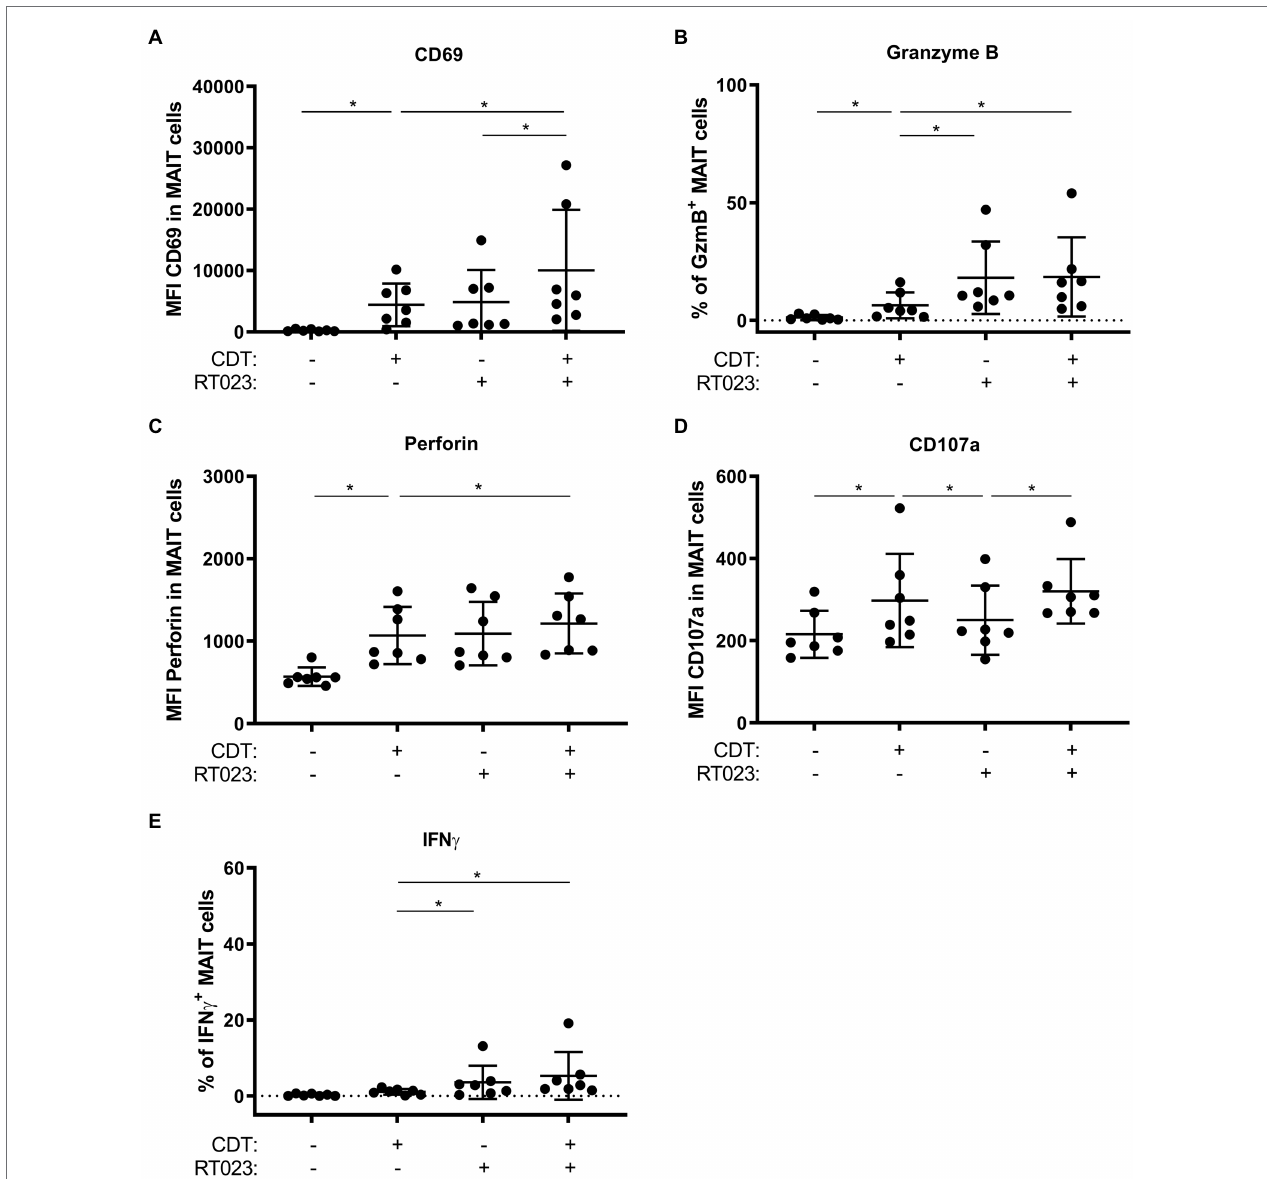
FIGURE 7 | MAIT cell effector phenotype following combined stimulation with hypervirulent C. difficile isolate RT023 and/or CDT. PBMCs were isolated from healthy donors and stimulated with C. difficile isolate with ribotype RT023 at MOI 1 and/or 100 ng/ml CDT for 20 h followed by flow cytometric analyses of CD69 (A) and CD107a (D) surface expression, internal granzyme B (B) , perforin (C) , and IFN γ (E) expression. Cells were gated on CD161 ++ V α 7.2 + CD3 + T cells (MAIT cells). Horizontal lines indicate mean fluorescence intensity/mean percentages ± SD. Asterisks indicate significant differences determined by six Wilcoxon matched- pairs signed rank tests with Bonferroni Holm correction: * p < 0.05. All conditions were pairwise tested against each other. Data of three independent experiments from seven donors are